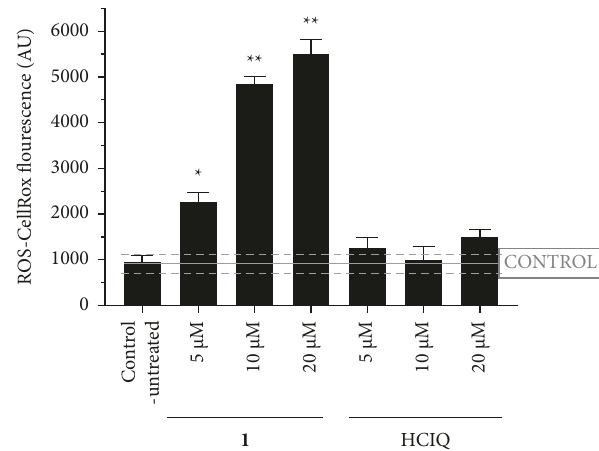
Figure 5: Quantification of ROS generated in RD cells after the treatment with the investigated compounds. The bar chart depicted an analysis of the mean fluorescence signal from the CellRox re- agent. Statistical analysis was calculated using unpaired t -test, and the statistically significant bars were marked with p 0 . ∗∗ ≤